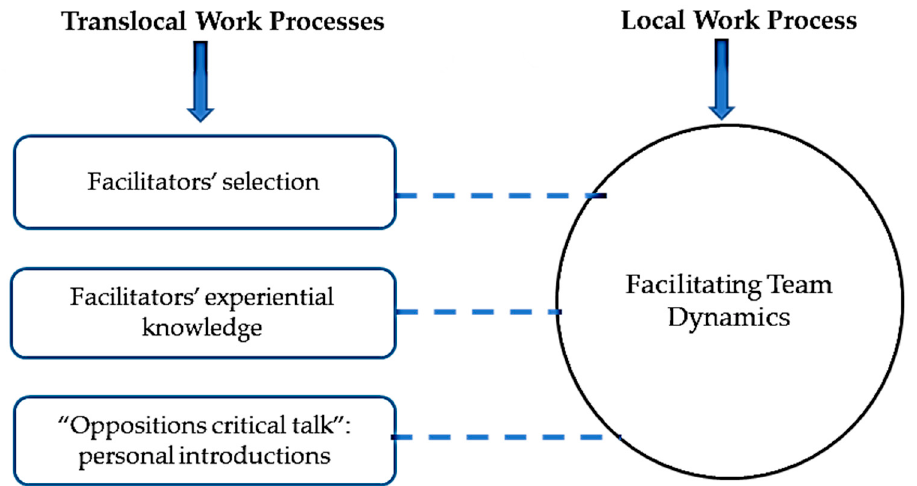
Figure 3. Facilitating Team Dynamics work process.